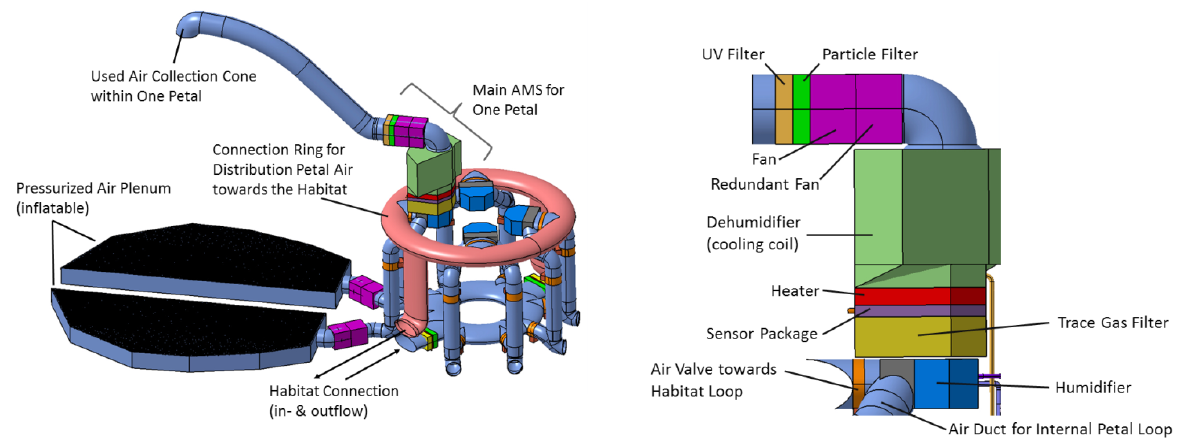
Figure 13: Illustration of the two operation modes.